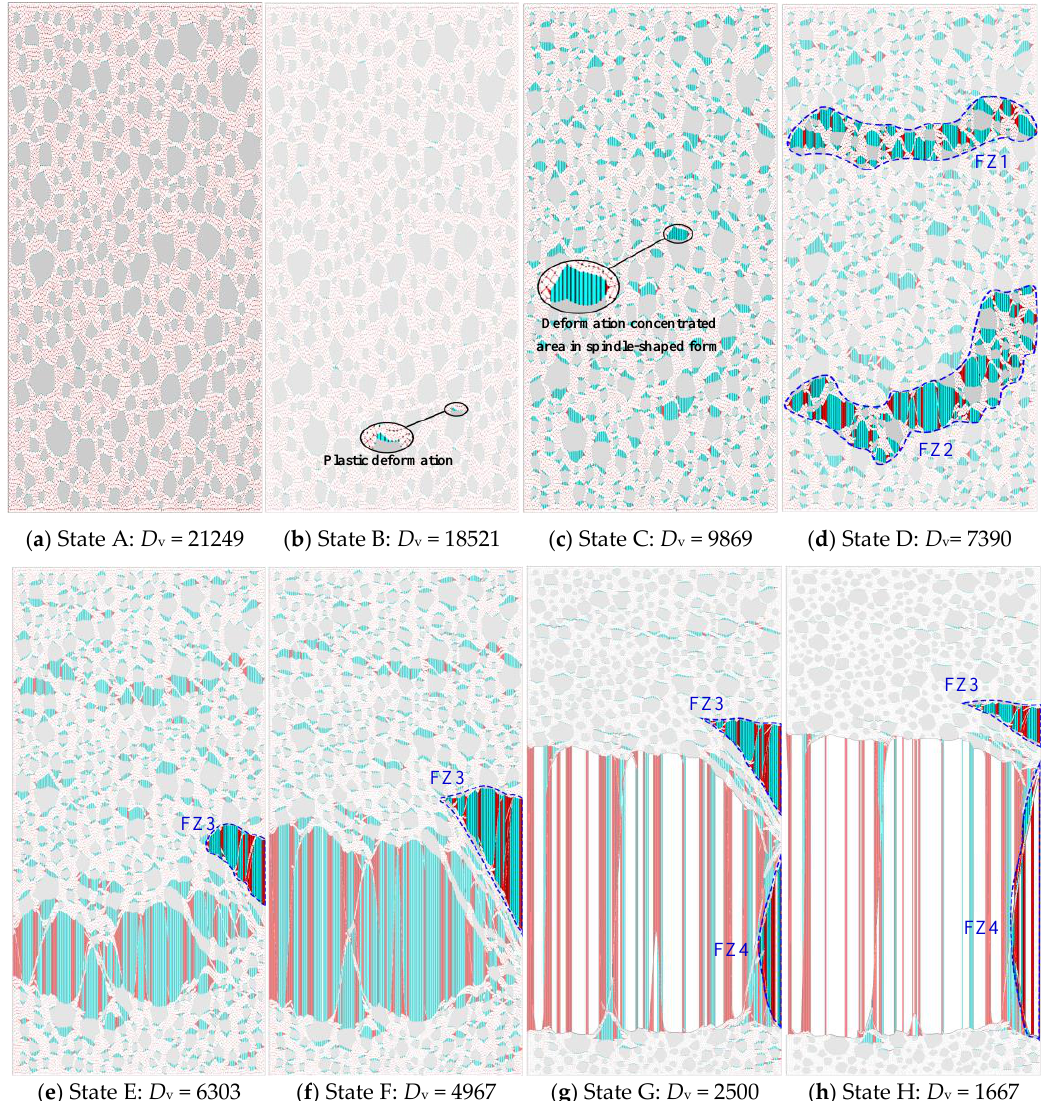
Figure 10. Deformation magnification in loading direction of a specimen in eight states. Cohesive elements of ITZs (blue coloured) and mortar internal interface (red coloured).